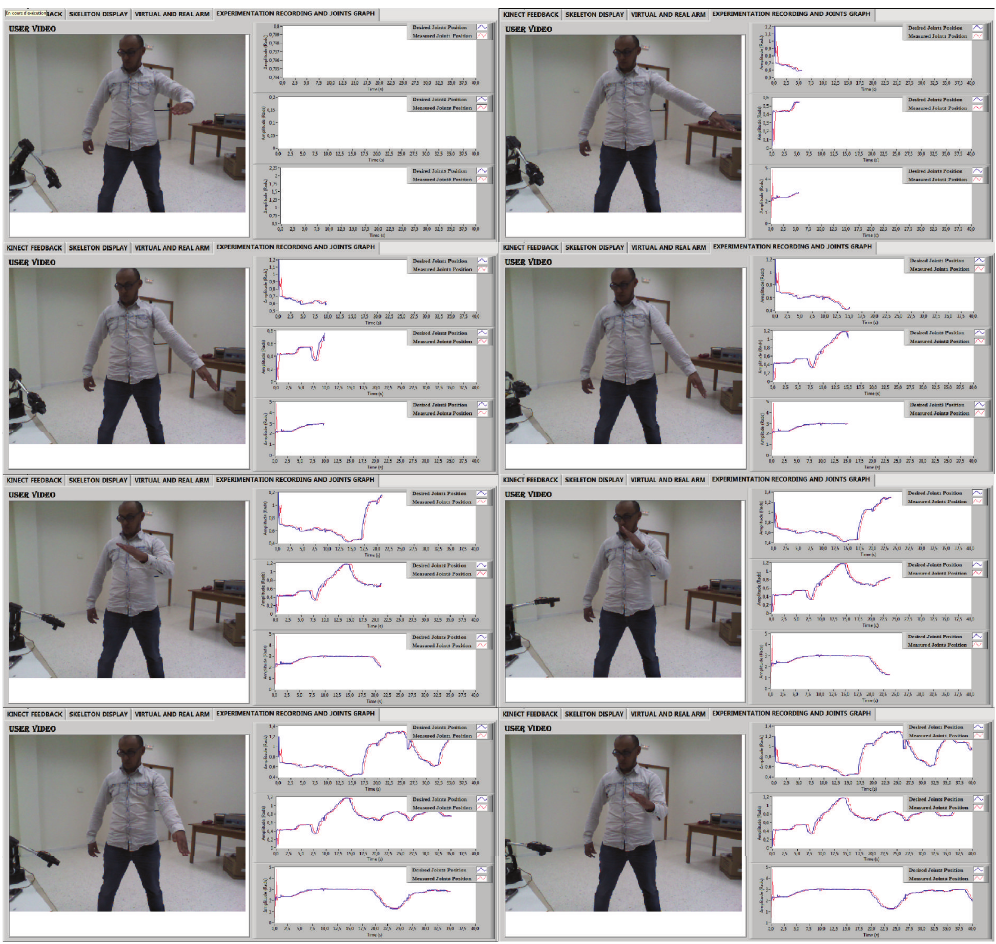
Figure 14: Gesture control process and real-time